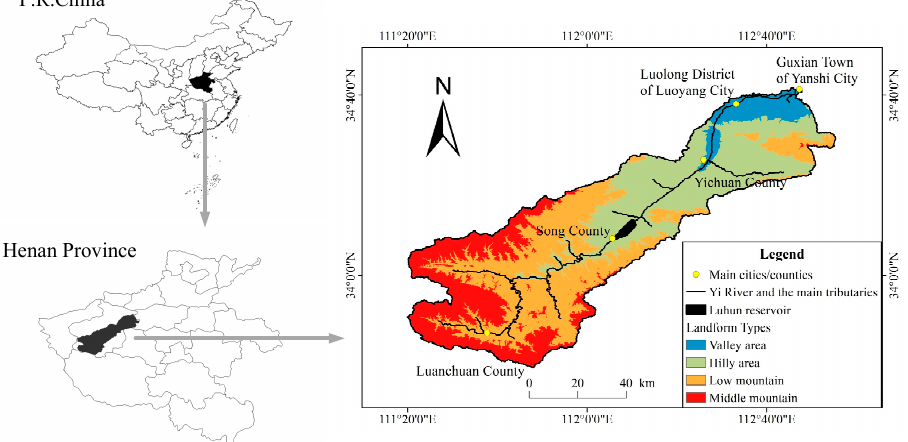
Figure 1. The location and elevation of the Yi River watershed in China.